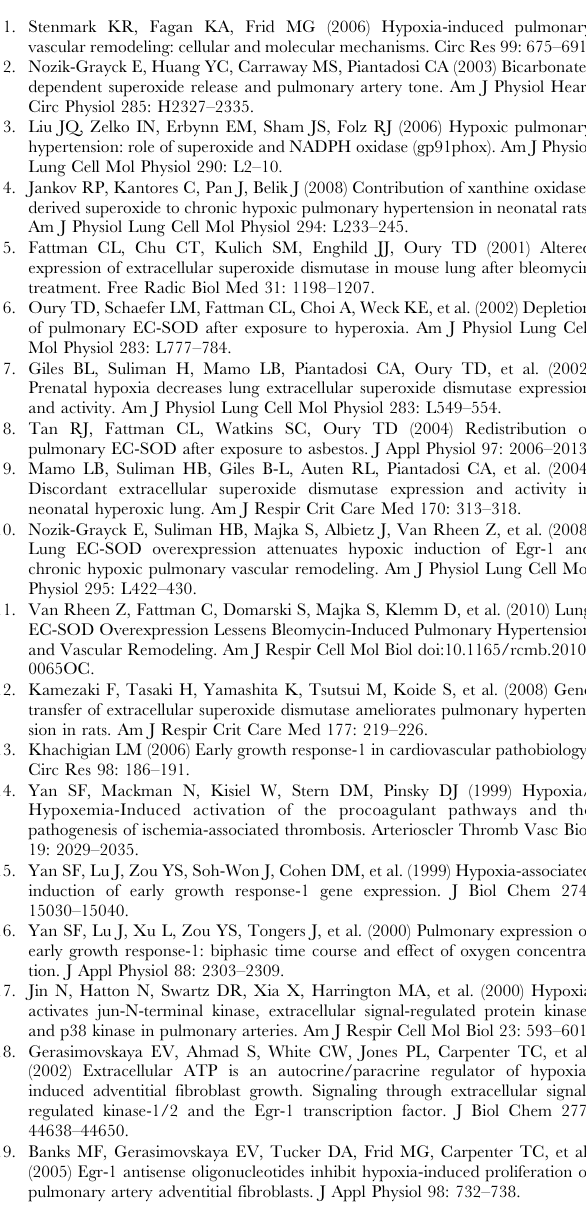
Figure S4 Ponceau S stain of the blot presented in Figure 7 to demonstrate equal protein loading. The membrane shown in Figure 7B was stained with Ponceau S to confirm equal nuclear protein